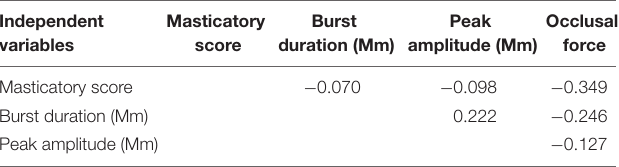
TABLE 4 | Bivariate Pearson’s correlation coefficients between independent variables of masticatory score, burst duration [masseter (Mm)], peak amplitude (Mm), and occlusal force in the regression analyses.